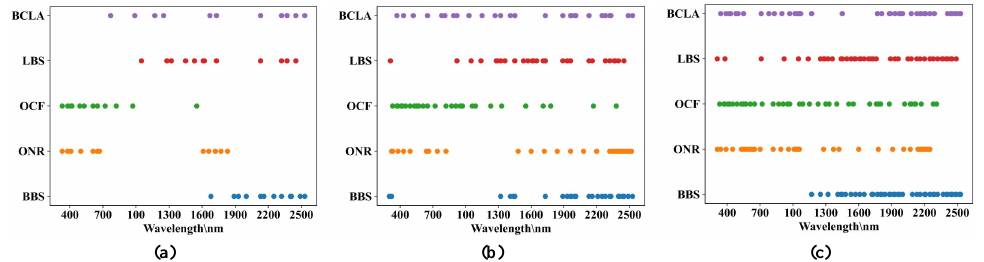
Figure 11. The band selection result with different selected band amounts for the compared band selection methods on the sea water data set. ( a ) 12 bands, ( b ) 27 bands, ( c ) 42 bands.